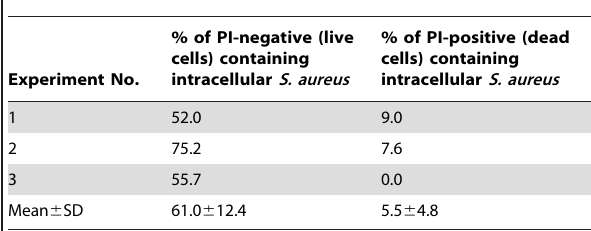
Table 2. Cell counts of viability assay experiments.